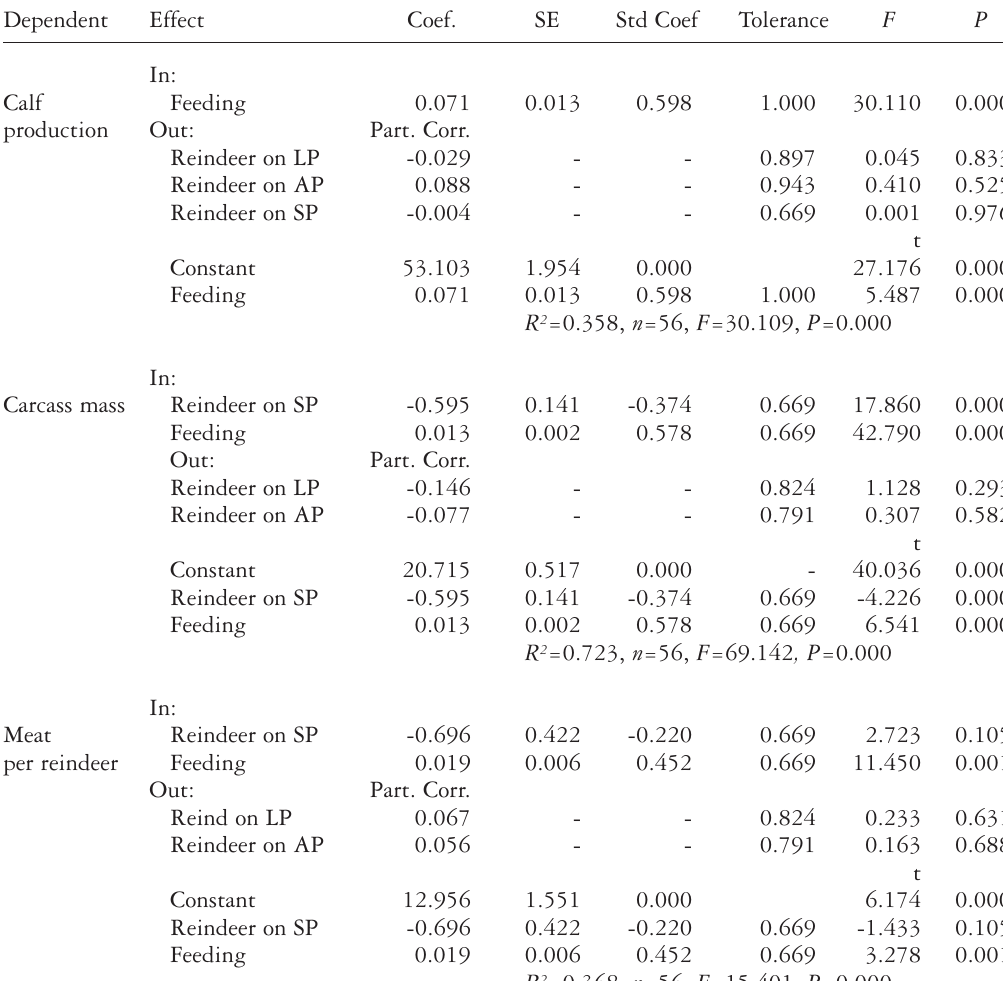
1. Dependence of calf production (%), carcass mass (kg) of reindeer calves and meat production per reindeer (kg/reindeer) on the four variables: reindeer density on lichen pastures (LP), reindeer density on arboreal lichen pasture (AP), reindeer density on summer pastures (SP) and amount of feed (kg) used per reindeer in winter. Backwards step-wise regression model (with Alpha-to- Enter = 0.150) and analysis of variance for full